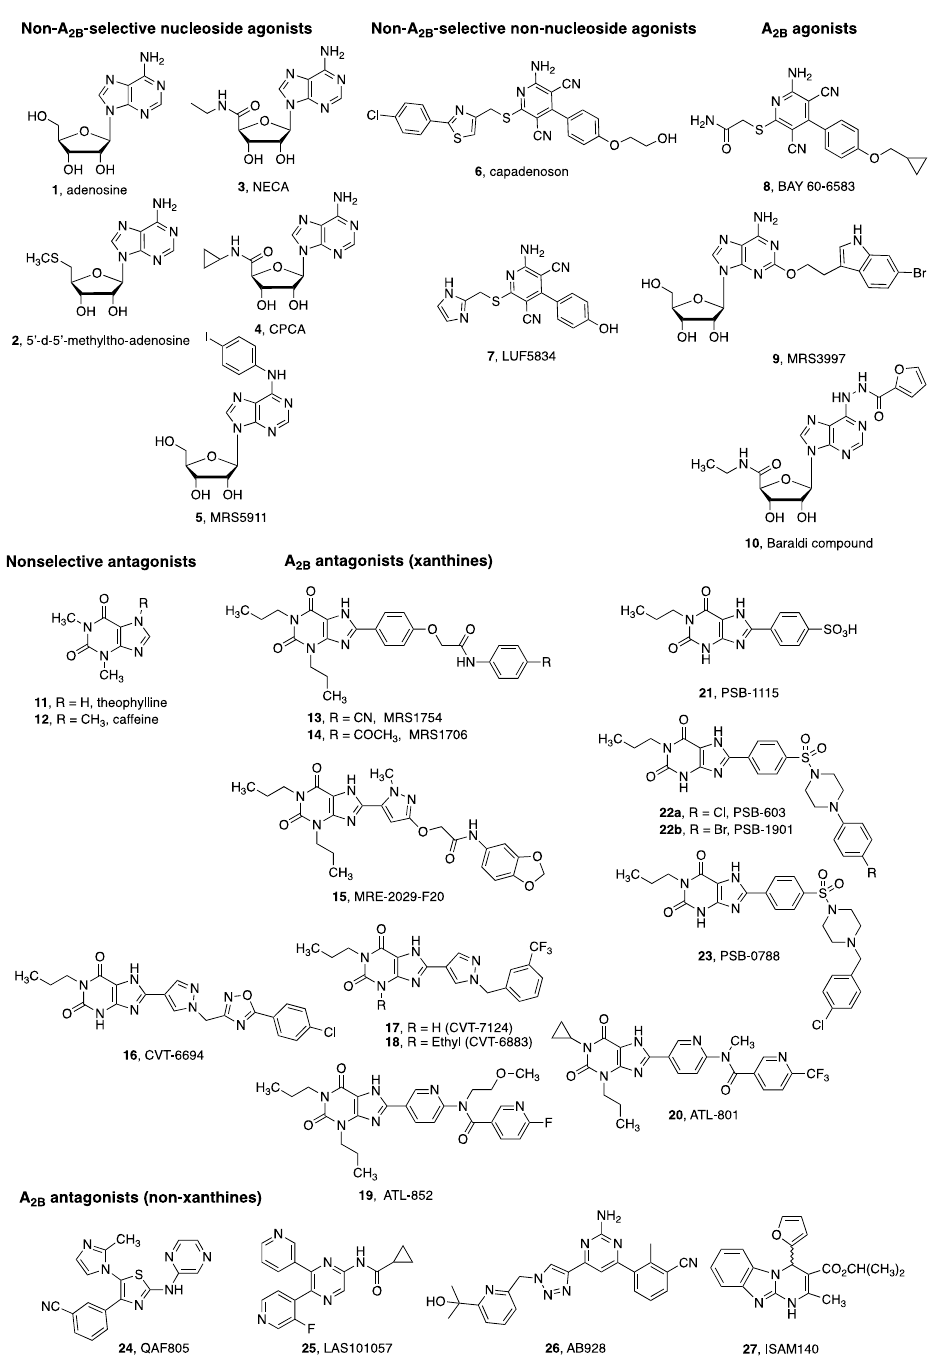
Figure 2. Chemical structures of both commercially available and literature-reported A 2B AR